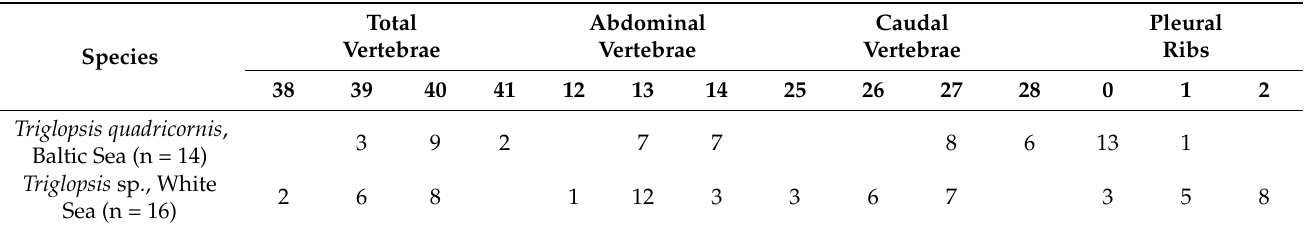
Table 3. Counts of vertebrae and pleural ribs for T. quadricornis from the Baltic Sea and Triglopsis sp. from the White